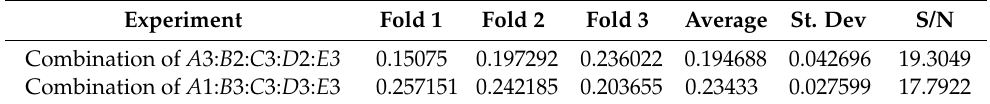
Experiment Fold 1 Fold 2 Fold 3 Average St.